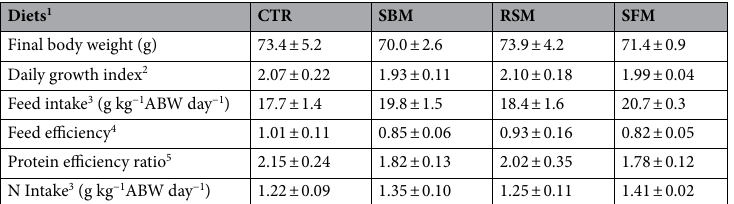
Table 1. Growth performance and feed utilization efficiency of European sea bass fed the experimental diets. Values presented as means ± standard deviation (± SD) (n = 3 per treatment pooled from 6 fish). 1 CTR, control fishmeal based diet; SBM, soybean meal based diet; RSM, rapeseed meal based diet; SFM, sunflower meal based diet. 2 DGI: ([final body weight 1 / 3 − initial body weight 1 / 3 ]/time in days) × 100. 3 ABW: average